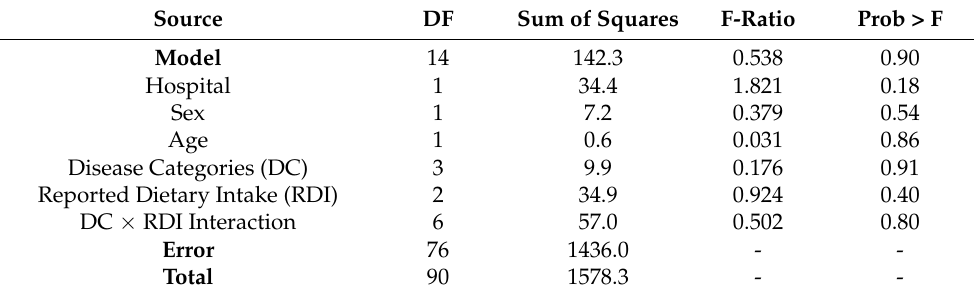
Table 4. Linear model output for MUAC